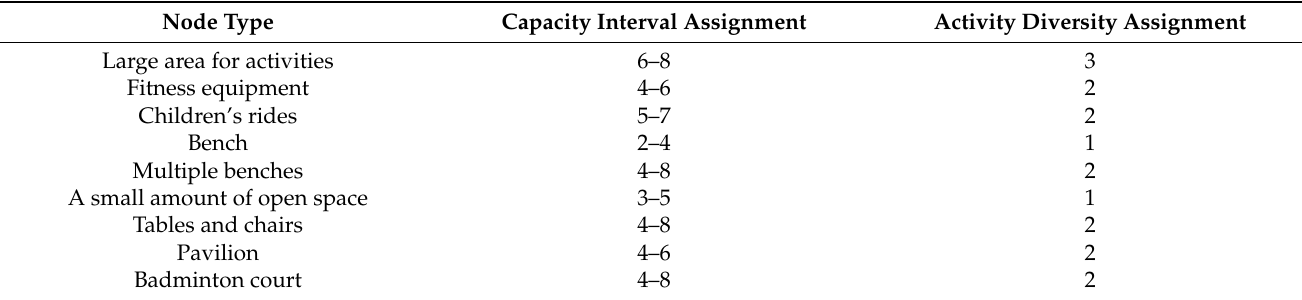
Table 2. Assignment criteria for node capacity / activity diversity of public space of sample af- fordable housing. Table 3. Summary of frequency of use, mean capacity and activity diversity data of public space nodes for affordable housing